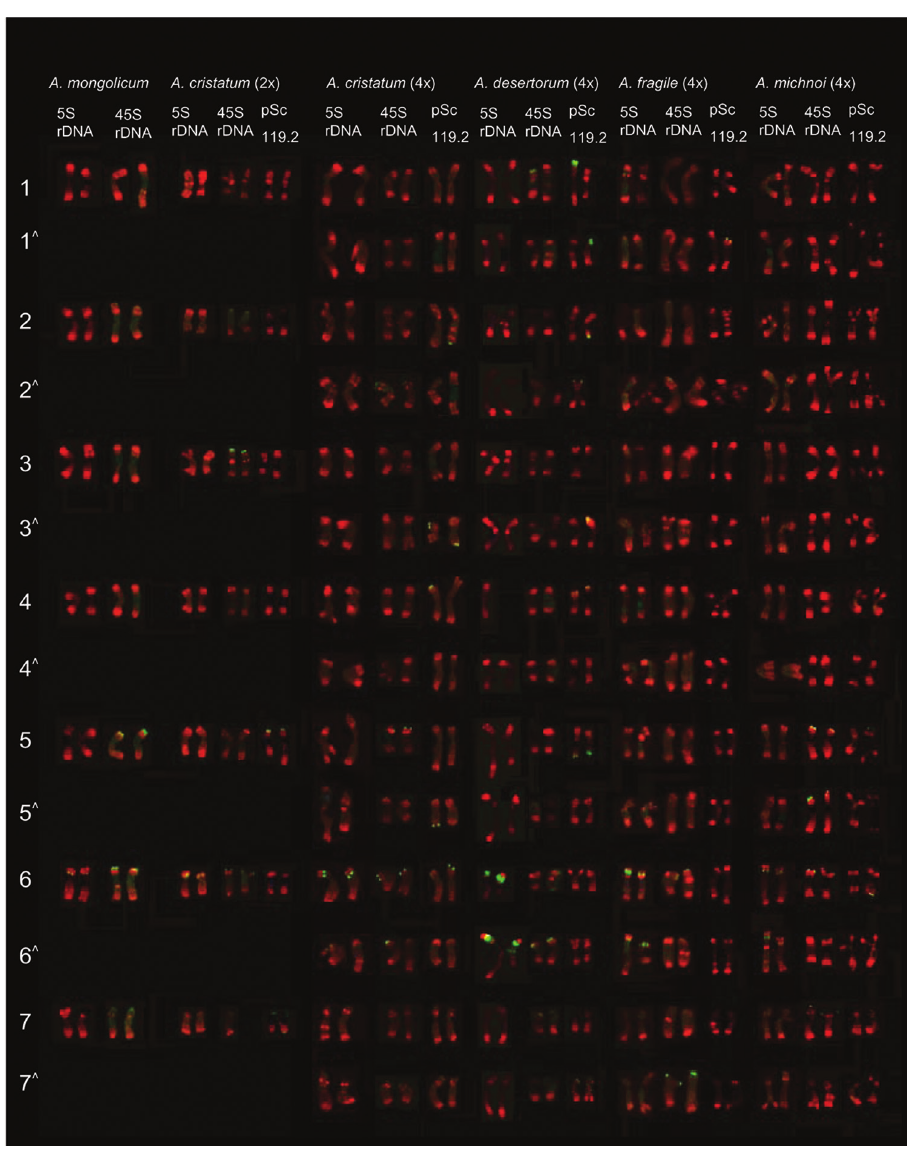
Figure 3. Molecular karyotypes of six Agropyron species probed using pAs1 (red) combined with 5S rDNA (green), 45S rDNA (green) or pSc119.2 (green) sequences. The numbers 1 to 7 designate seven different homologous chromosomes, whereas the same number followed by “^” indicates the respective homoeologous chromosomes in each genome of tetraploid